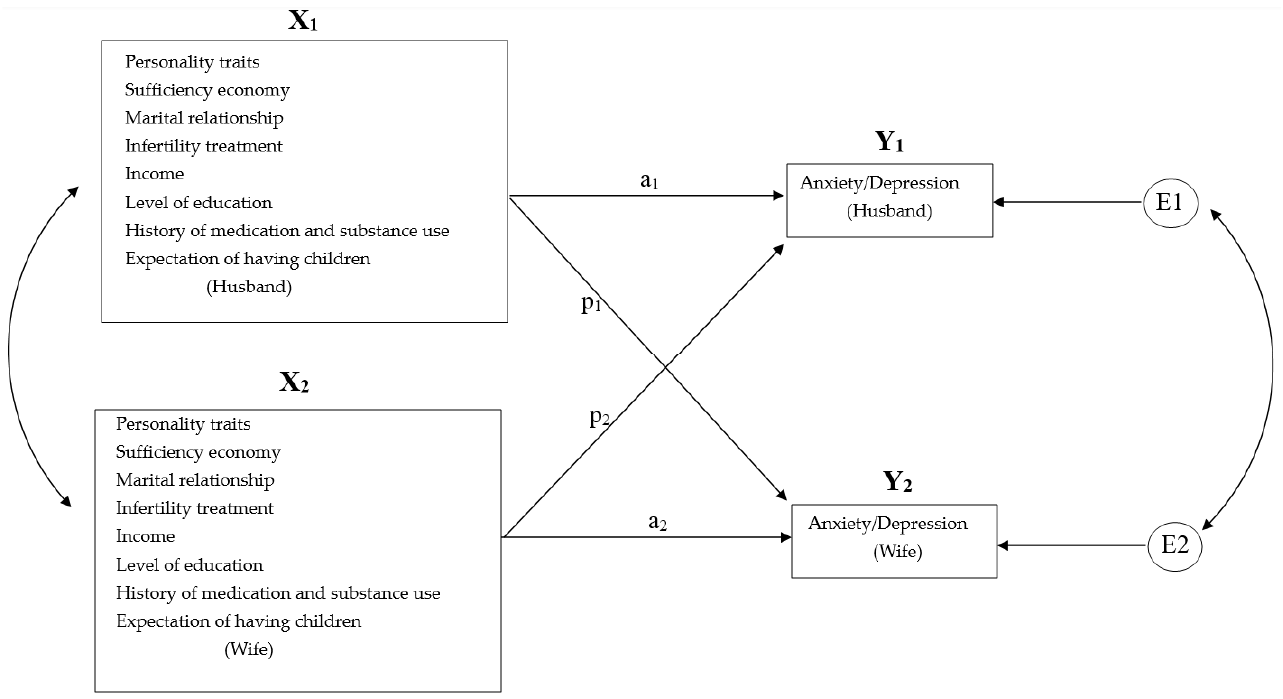
Figure 1. Actor–partner interdependence model (APIM) shows the actor effect, partner effect and interaction effect in infertile couples, e.g., X1: marital satisfaction; X2: wives’ marital satisfaction; Y1: husbands’ anxiety/depression; Y2: wives’ anxiety/depression; E1 & E2: corresponding error terms.